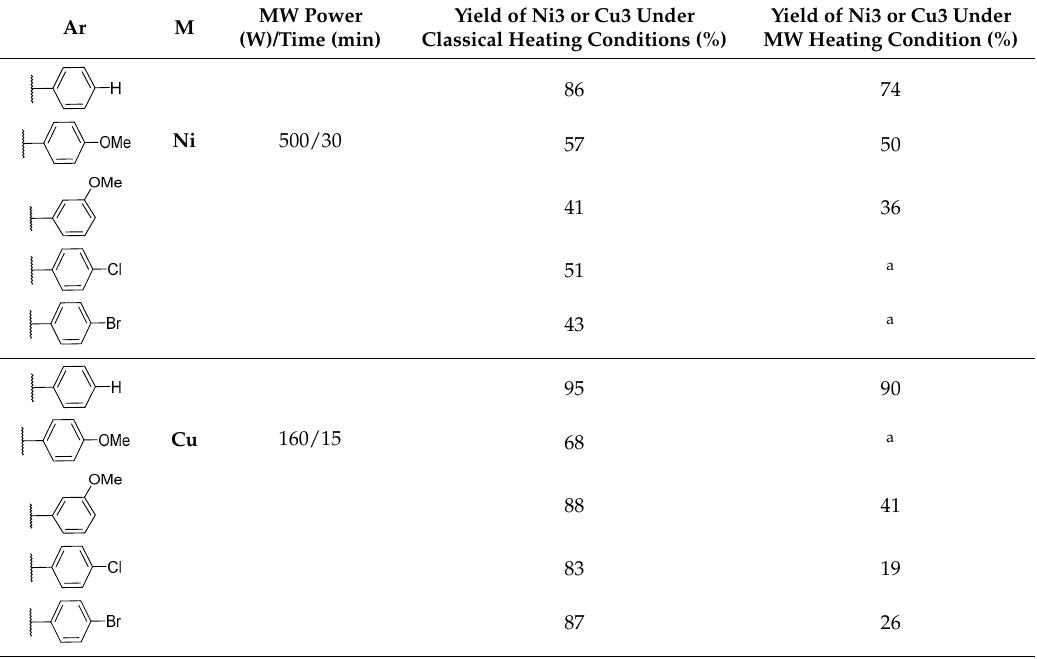
Table 1. Vilsmeier–Haack formylation of the Ni(II) and Cu(II) complexes of 5,10,15,20- tetraarylporphyrins under MW conditions.